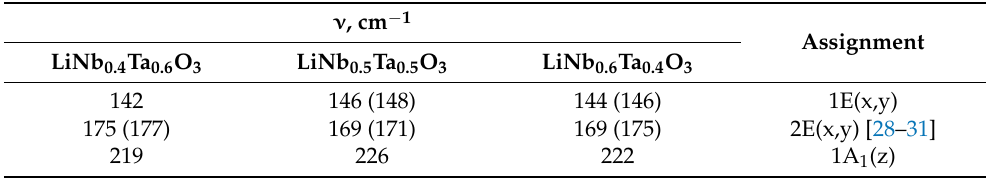
Table 2. Frequencies of polar modes of LNT ceramic solid solutions registered in this work and their assignment taking into account the results of